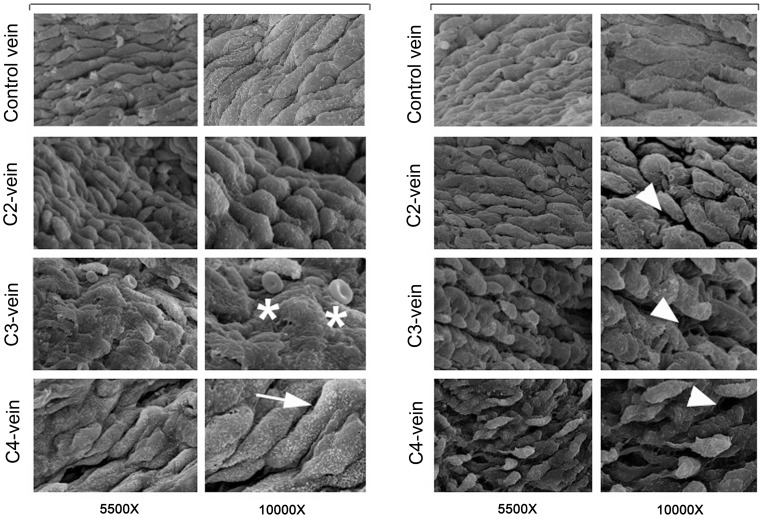

In situ morphological characterization of large vein endothelium.Morphological investigation of endothelium obtained from control and CVD (from C2 to C4 stages) veins was performed by SEM. A representative panel composed of images from 2 control specimens and 6 pathological veins (2 for each CEAP stage) is shown. In C2-, C3- and C4-veins, luminal pathological vessel surfaces were covered by endothelial cells characterized by an irregular orientation and several morphological abnormalities, such as: discontinuous surface of the endothelium (arrowheads), which increases with the severity of the disease, presence of plaques covering the endothelial surface (asterisks) and/or presence of numerous microvilli (arrow). Red cells adhering to endothelium were frequently observed (left C3 images).